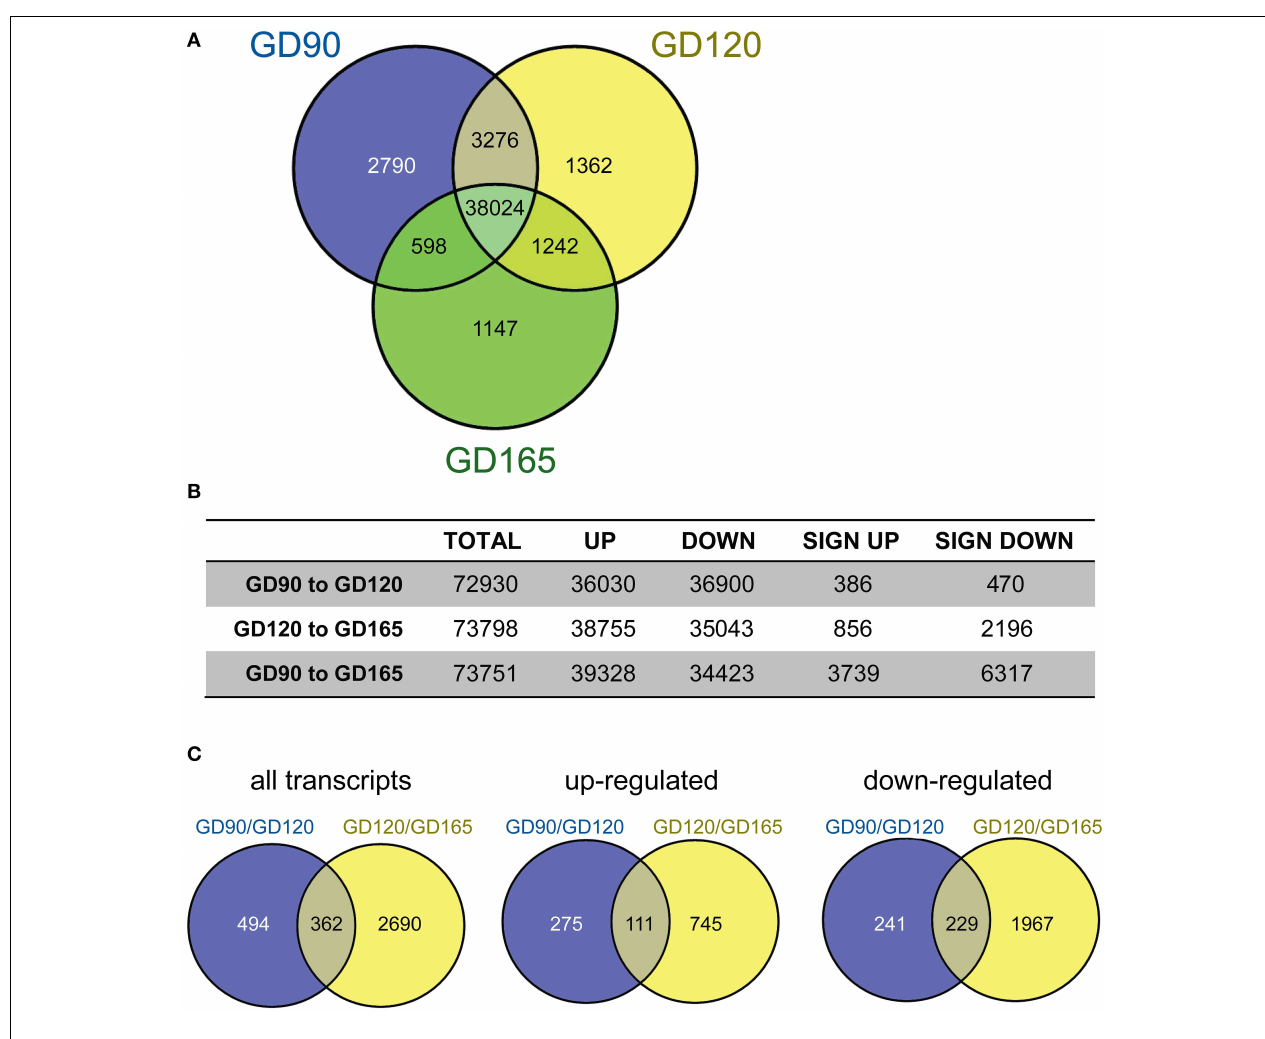
FIGURE 1 | (A) Venn-diagram showing the number of transcripts present at gestational day (GD) 90 (blue), 120 (yellow), and 165 (green) in the fetal baboon choroid plexus. A transcript was considered present when the majority of animal at each age had > 1 transcript and the median number of transcripts was > 10. The majority of transcripts were present at all ages (78%). The number of unique transcripts decreased with developmental age with 2790 at GD90, 1362 at GD120 and 1147 at GD165. (B) Pairwise comparisons of the number of up/down regulated